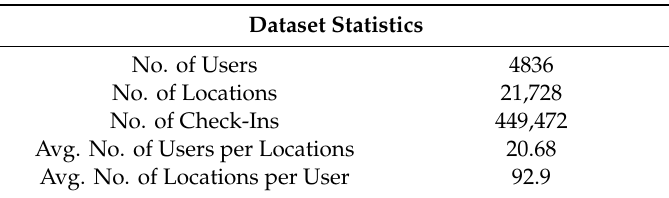
Table 1. Dataset